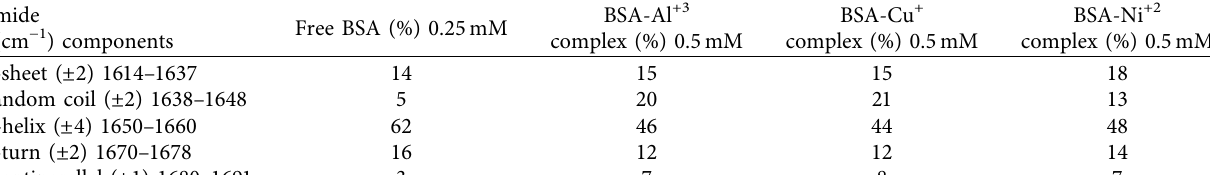
Table 1: Secondary structural study of the Cu + , Ni +2 , and Al +3 complexes of free BSA. Amide